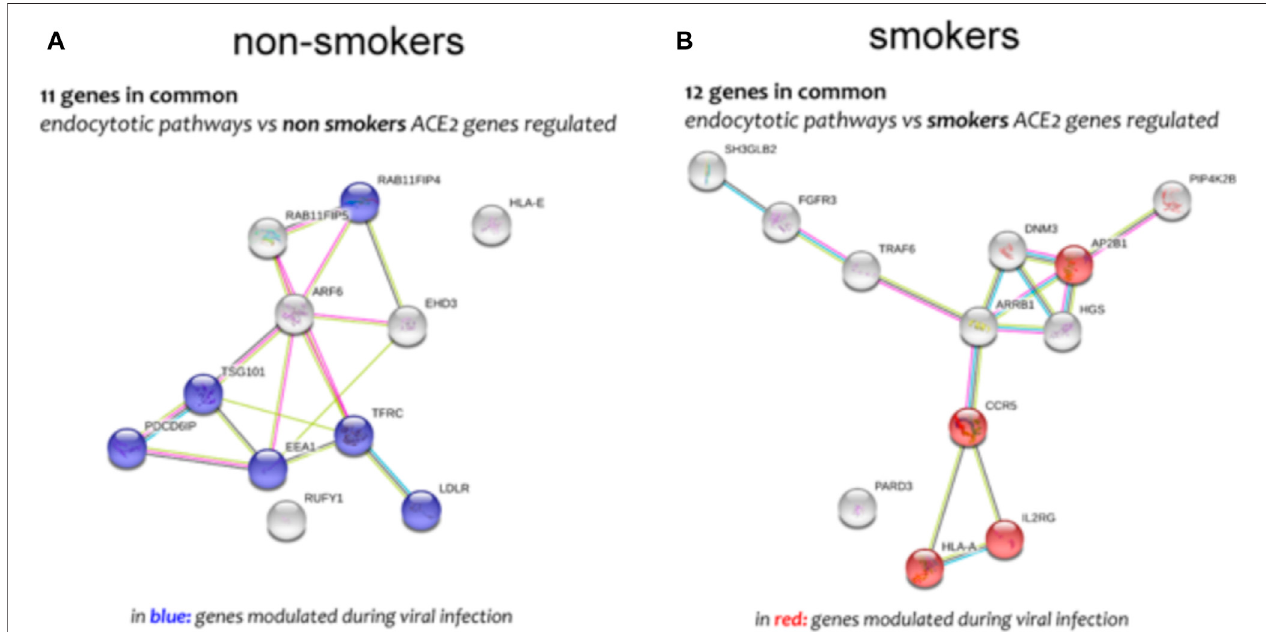
FIGURE10| Genesnetworkanalysisofmaingeneshighly correlatedto ACE-2 innon-smokers (A) andsmokers (B) SAE cells,performedbyonlinetoolsSTRING.